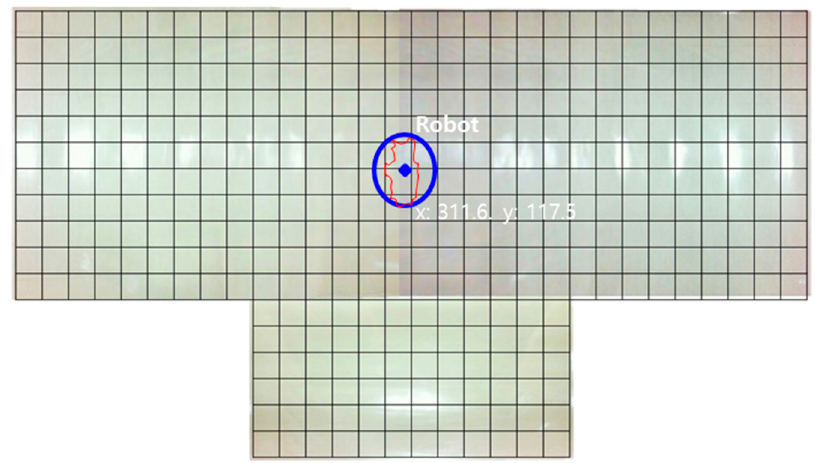
Figure 21. Experimental results of the two-dimensional map using the proposed localization